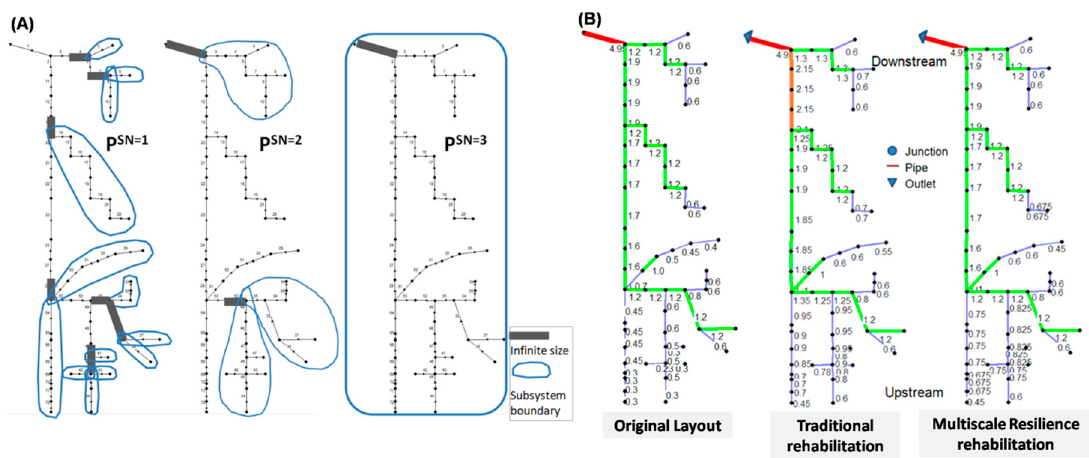
Figure 7. ( A ) “Sewer branch order” and network decomposition of the case study UDS and ( B ) comparison between traditional and multiscale resilient UDS design.